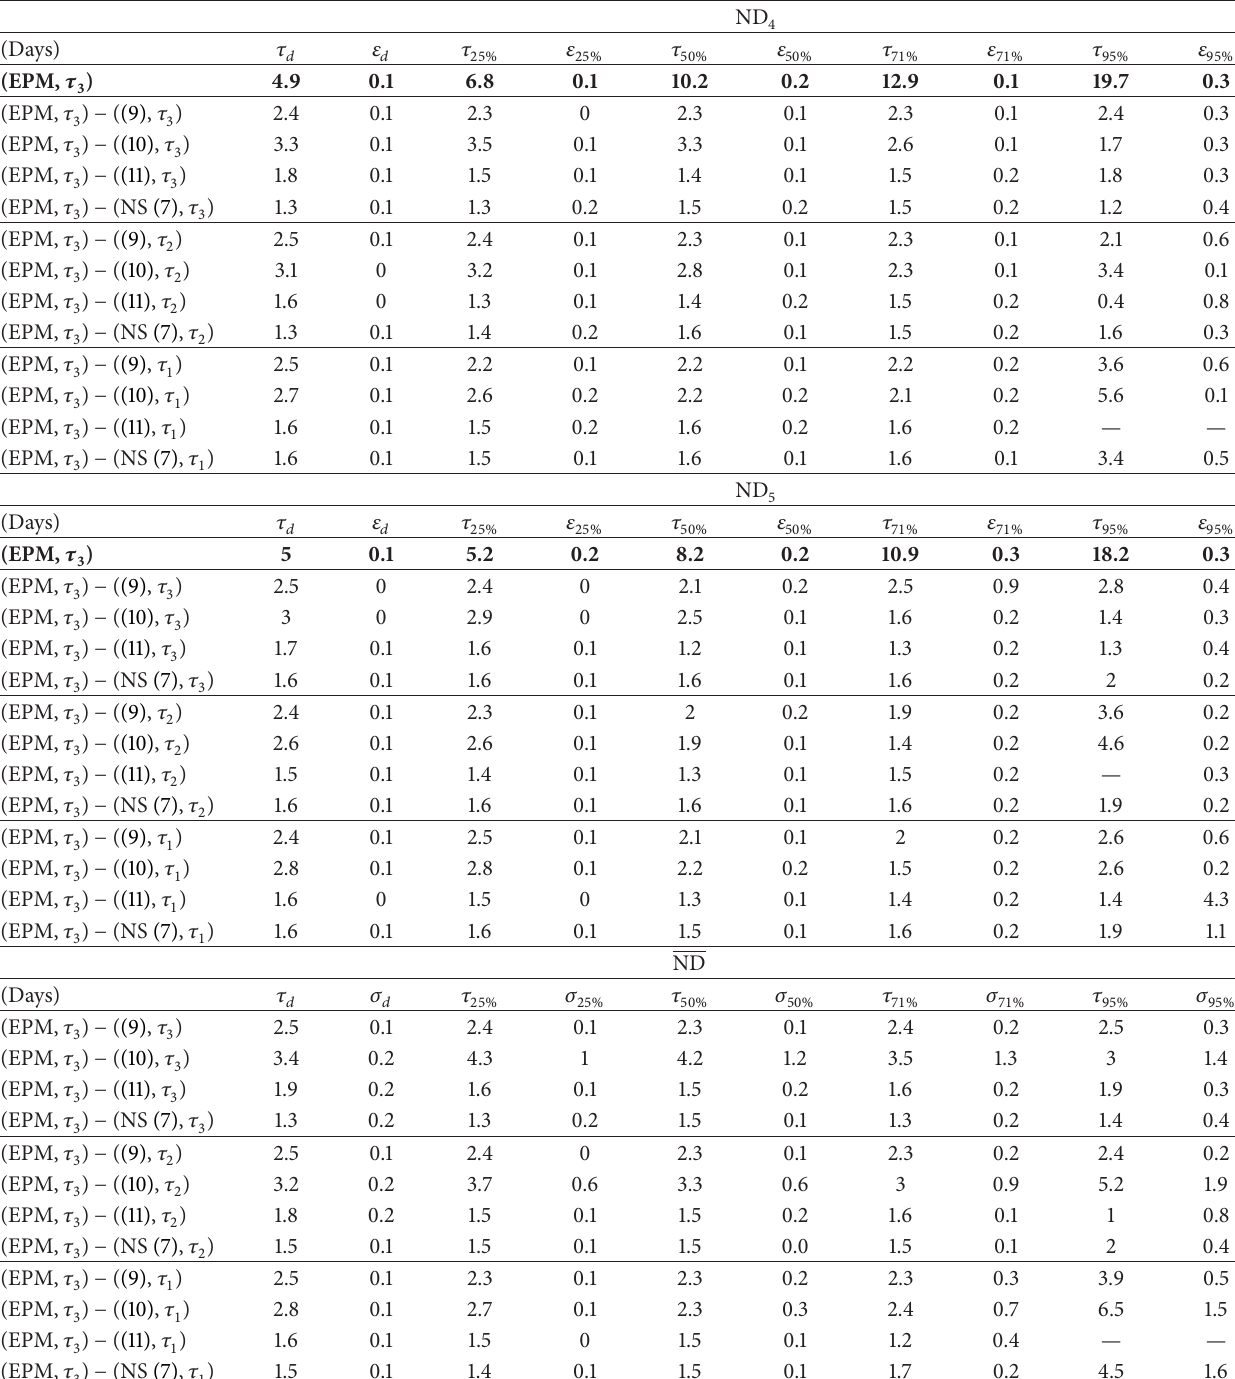
Table 2: Average values over 𝑀 1,...,5 of time limits (in days) for model values (EPM), for normal distributions ND 4,5 , and for prediction time length 𝜏 3 (bold rows), difference between this model values and average values over 𝑀 1,...,5 received from (9)–(11) and NS (7) with parameters a , b , c , g, 𝑎 𝑚 , 𝑏 𝑚 , 𝑠 𝑚 , 𝑐 𝑚 , 𝑔 𝑚 , and 𝑙 𝑚 calculated from approximations of (4)–(7) for 𝜏 1 , 𝜏 2 , 𝜏 3 and 𝑀 1,...,5 (columns 𝜏 𝑑 , 𝜏 25 % , 𝜏 50 % , 𝜏 71 % , 𝜏 95 % ). Standard deviation of 𝑀 1,...,5 (columns 𝜀 𝑑 , 𝜀 25 % , 𝜀 50 % , 𝜀 71 % , 𝜀 95 % ) and average value ND and standard deviation (columns 𝜎 𝑑 , 𝜎 25 % , 𝜎 50 % , 𝜎 71 % , 𝜎 95 % ) of ND 1,...,5